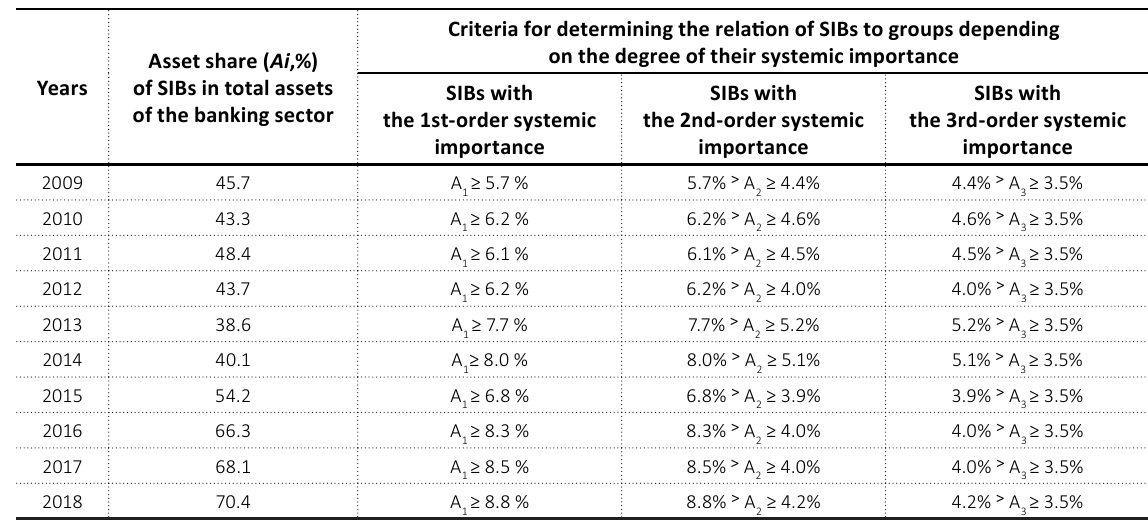
Table 1. Criteria for determining the relation of Ukrainian systemically important banks to three groups depending on the degree of their systemic